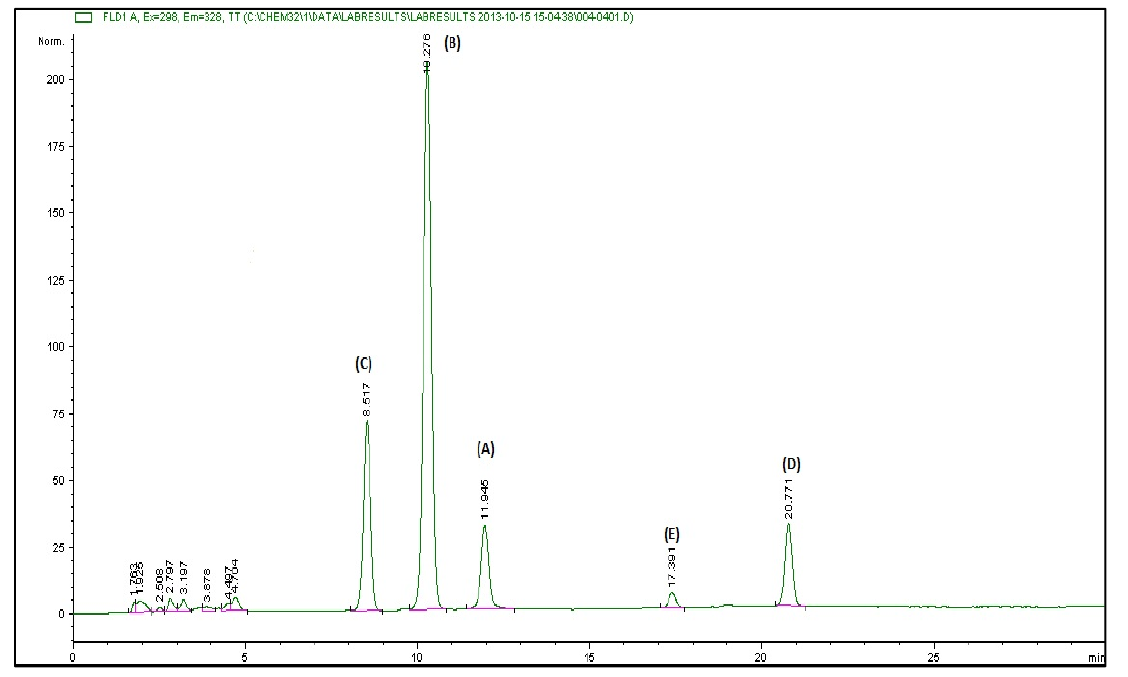
Figure 1. HPLC chromatogram showing different isoforms of vitamin E in the RPO used in the study ( A ) α -tocotriemol ( B ) β / γ -tocotrienol ( C ) δ -tocotrienol ( D ) α -tocopherol ( E ) δ -tocopherol. Table 2. Phytochemical and fatty acid constituent of RPO. Constituents Concentration